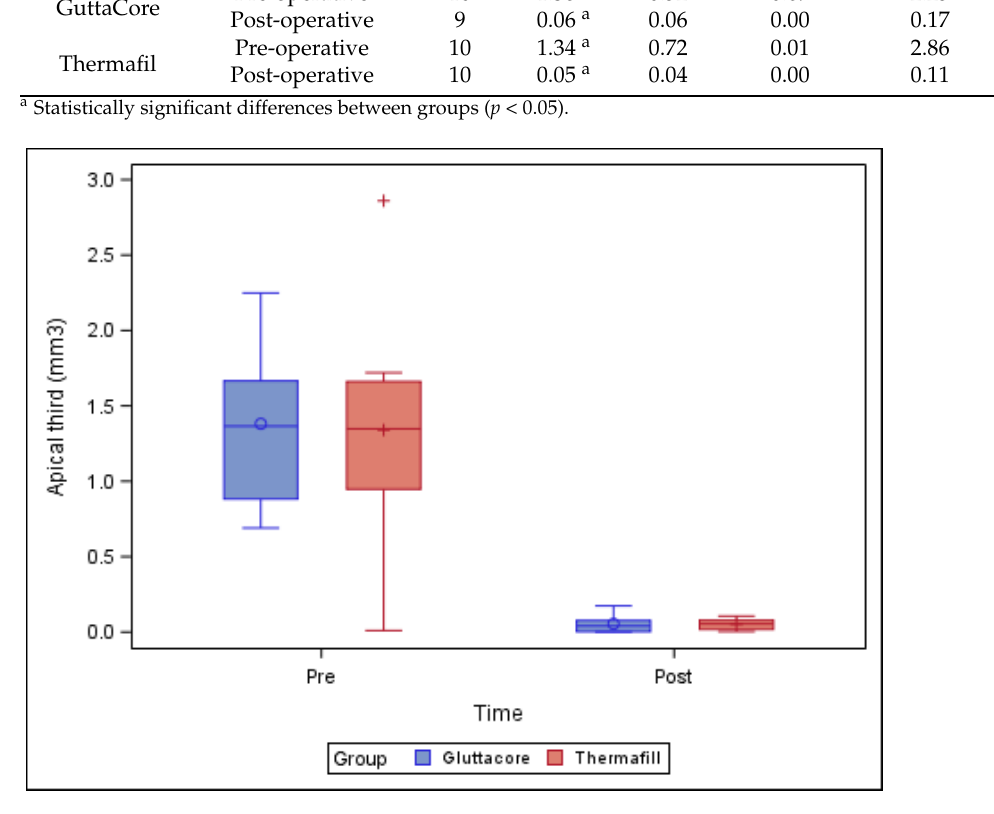
Table 4. Descriptive analysis of the proportion (%) between the volume of the root canal system and the remaining carrier-based root canal filling material volume from the coronal, middle and apical thirds.